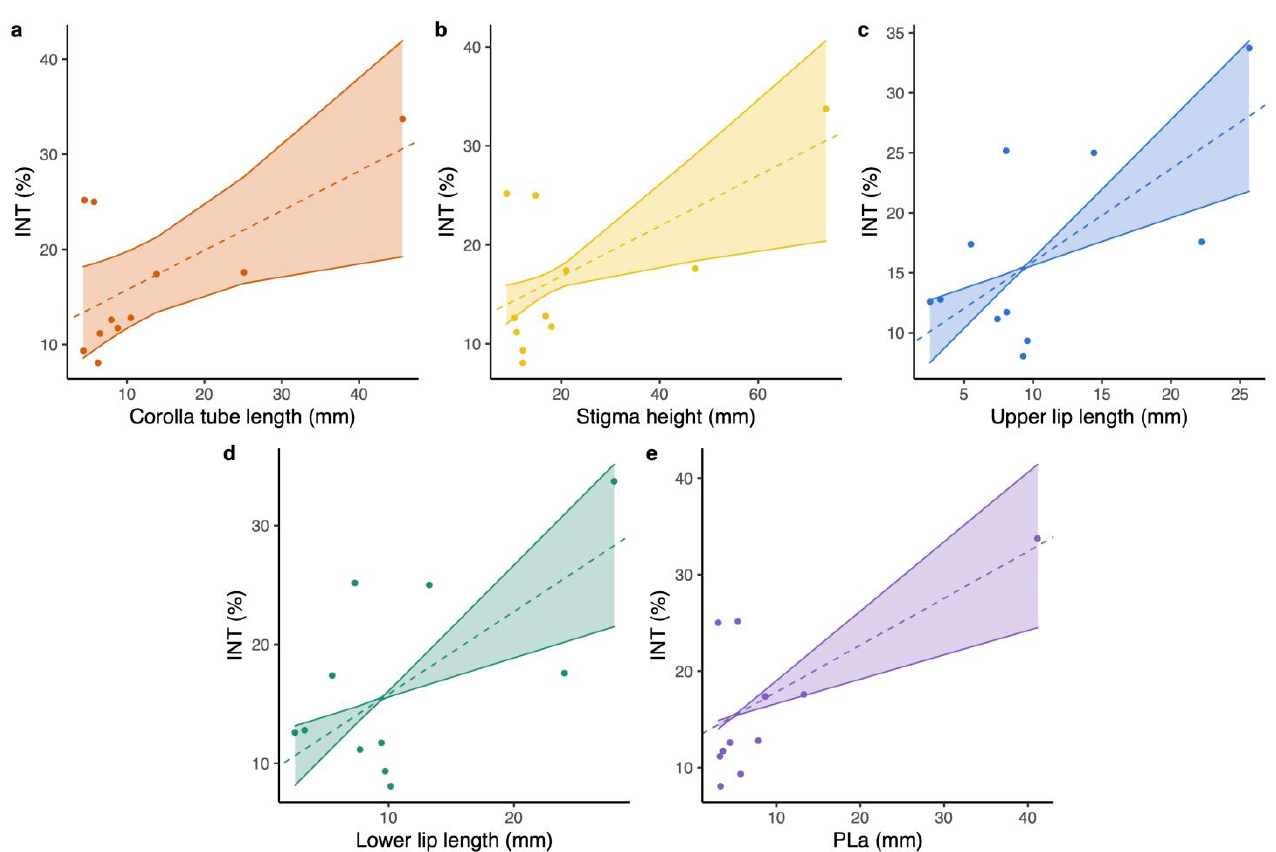
Figure 2. PGLS results on the correlation between: ( a ) corolla tube length and floral integration index (INT), ( b ) stigma height and INT, ( c ) upper lip length and INT, ( d ) lower lip length and INT, and ( e ) the composite pollinator proboscis length of the pollinator assemblage (PLa) and INT for the studied Lonicera flowers.